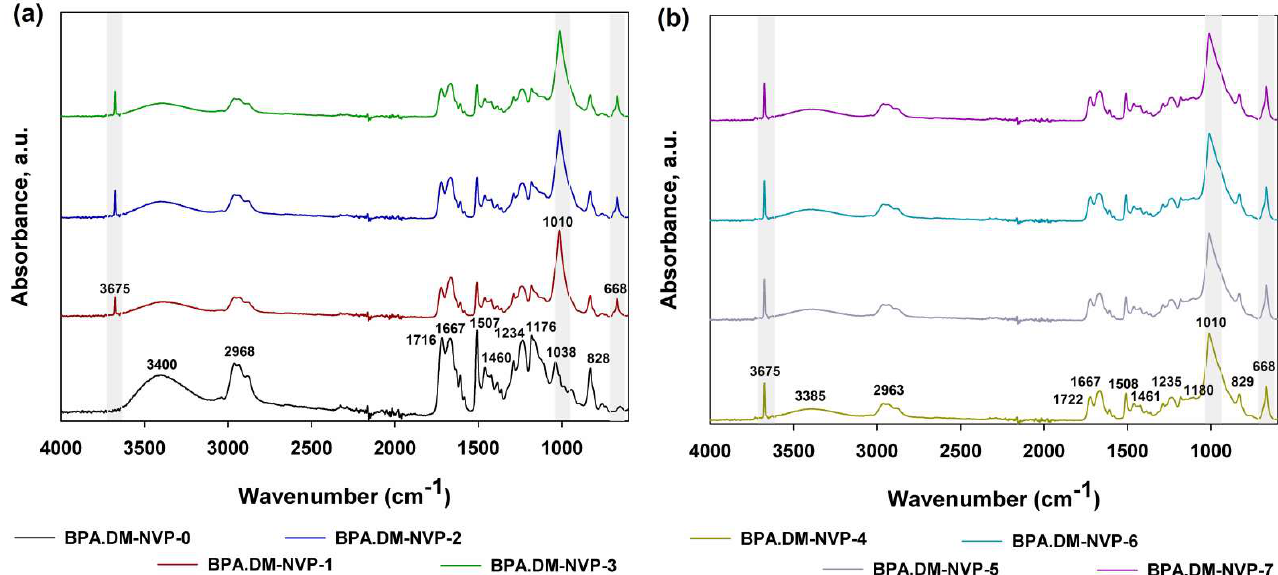
Figure 4. ATR/FTIR spectra of the prepared composites: BPA.DM-NVP-0–BPA.DM-NVP-3 ( a ) and BPA.DM-NVP-4–BPA.DM-NVP-7 ( b ).